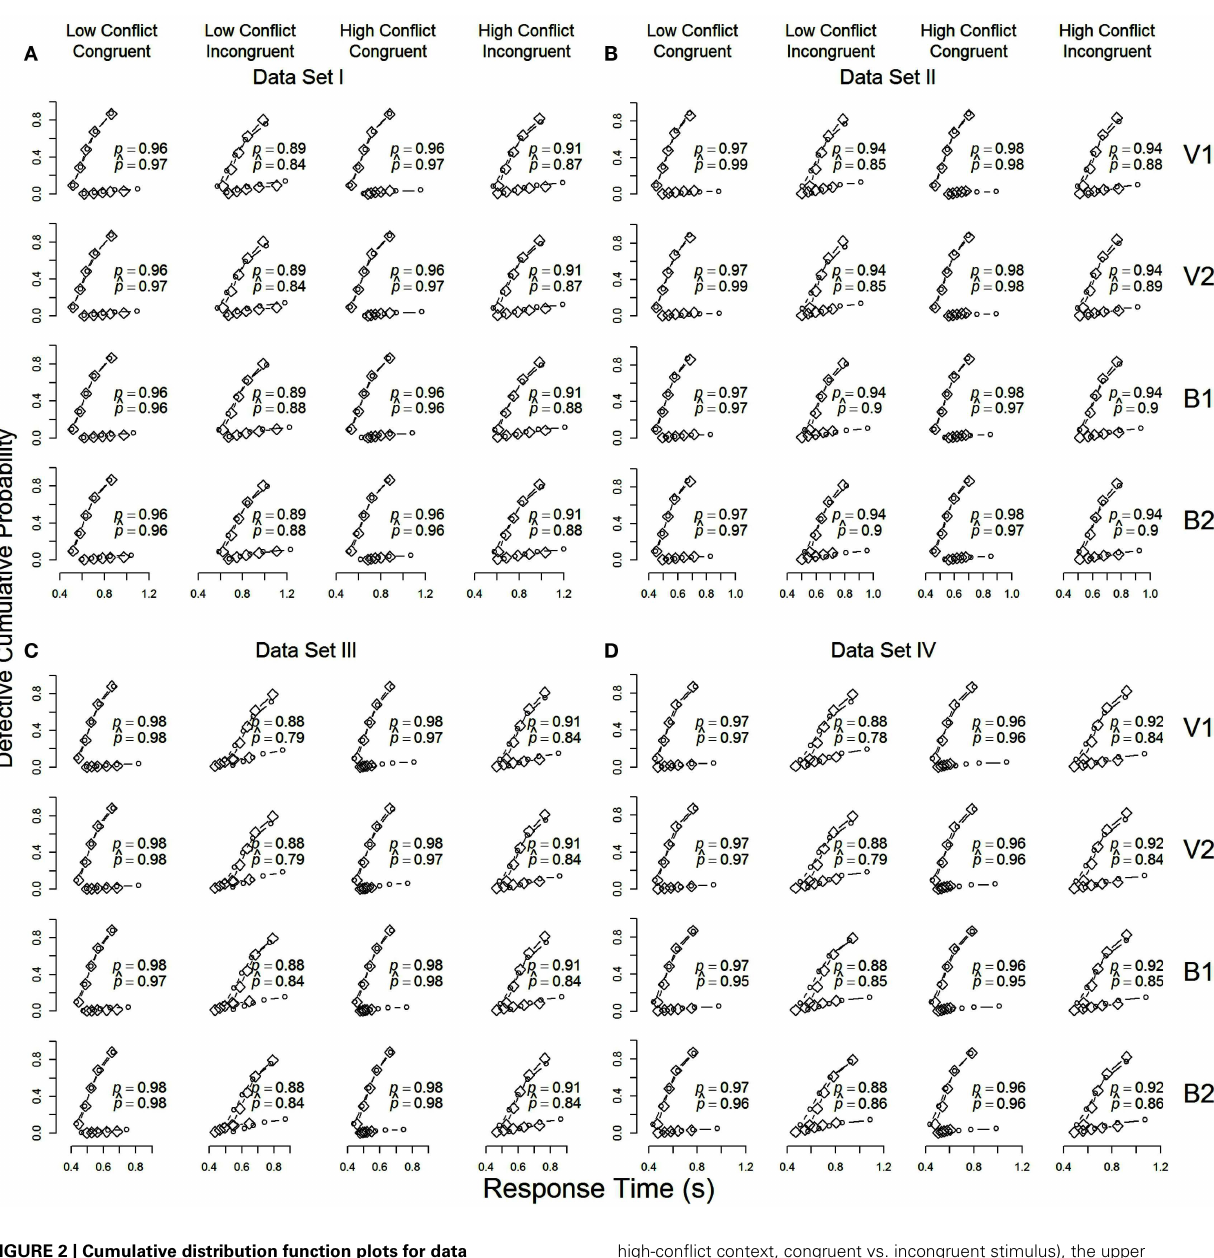
high-conflict context, congruent vs. incongruent stimulus), the upper function presents results for correct response, and the lower function presents results for incorrect responses. For each condition, the observed and predicted proportion of correct responses are shown using p and ˆ p ,